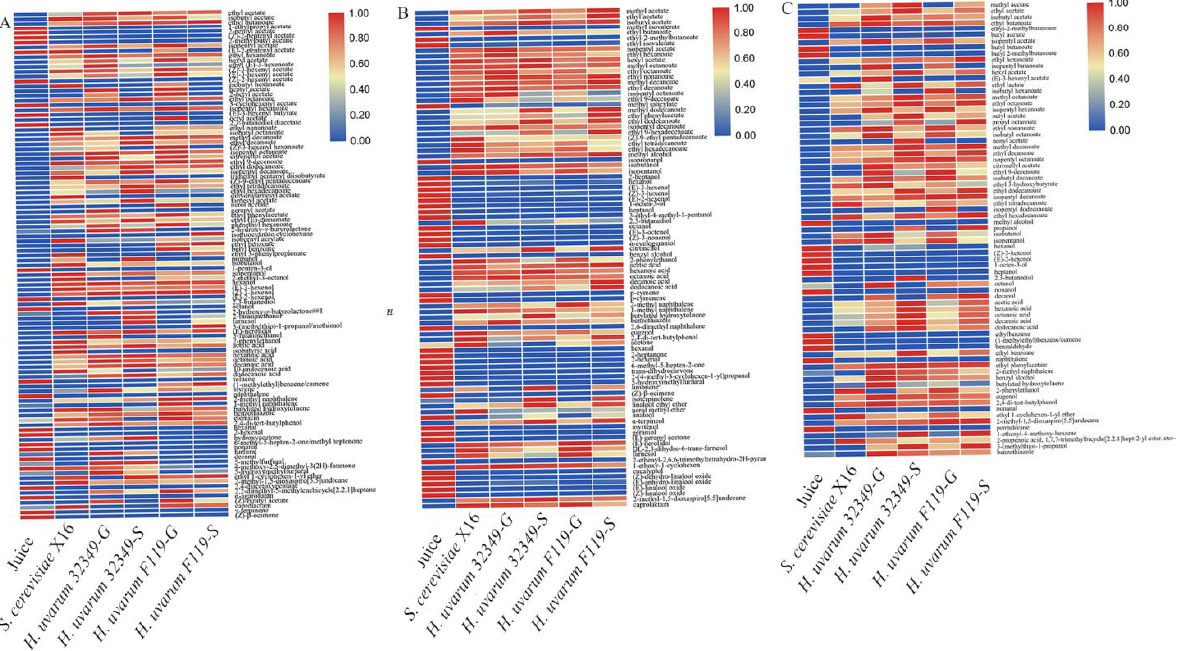
Figure 2. Heatmap of R. roxburghii wine, blueberry wine, and plum wine. ( A ) R. roxburghii wine; ( B ) blueberry wine; ( C ) plum wine.